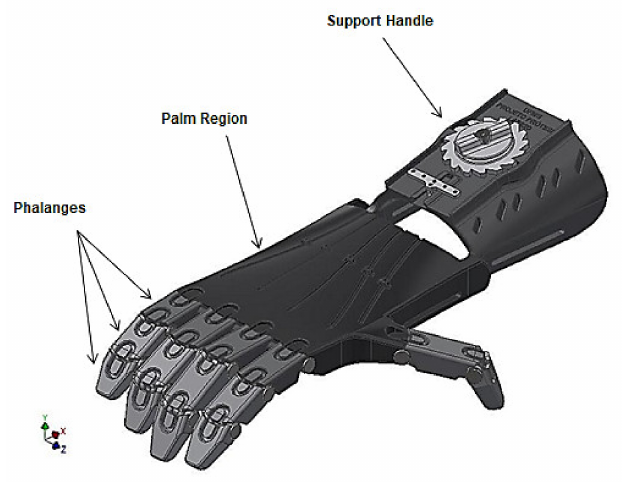
Figure 17. Mechanical CAD prosthesis 3D CAD